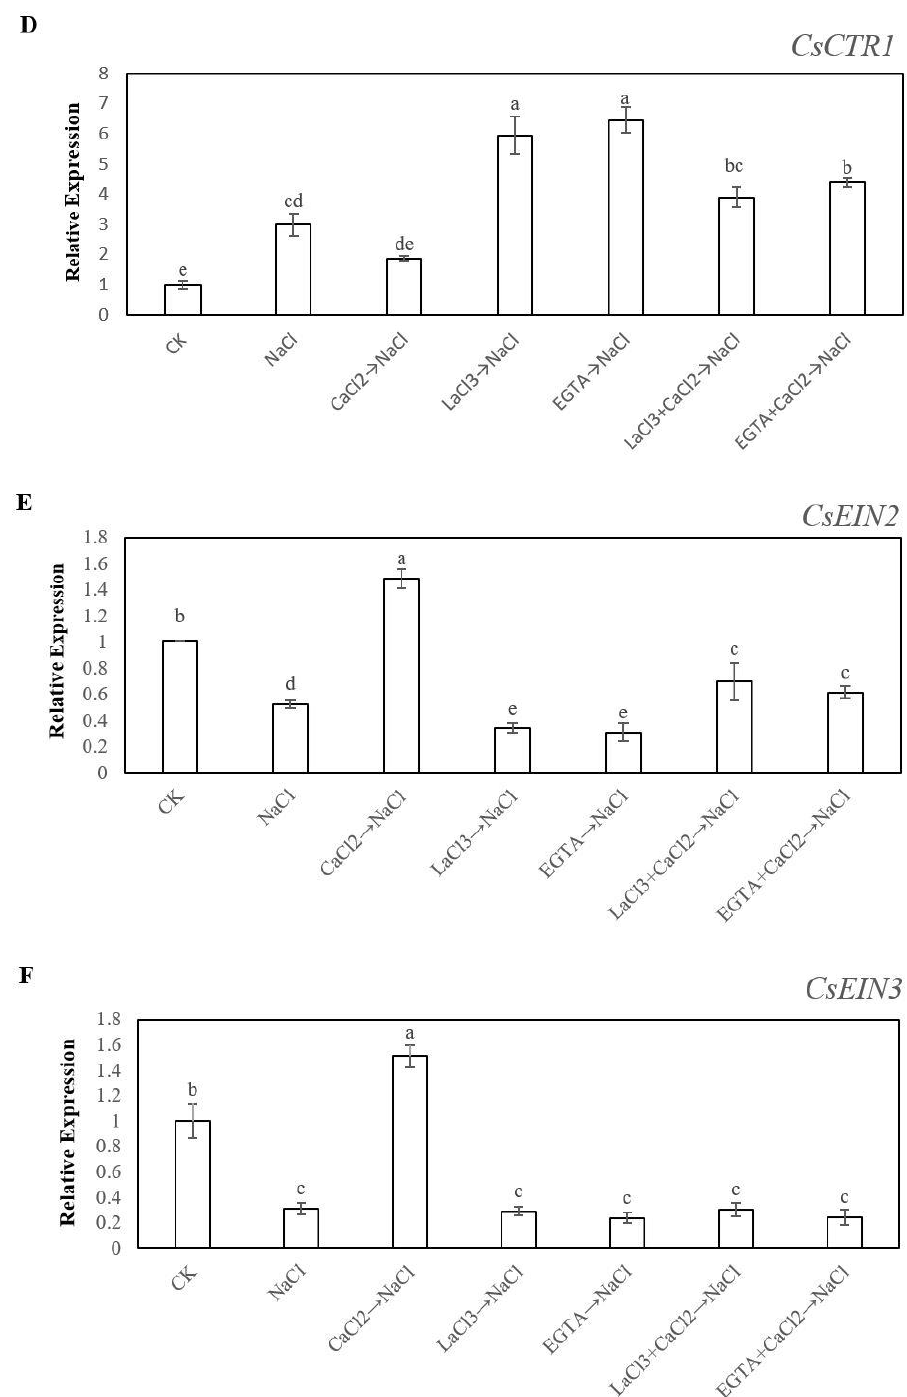
Figure 7. Effects of Ca 2+ on the Expression Levels of CsETR1 ( A ), CsETR2 ( B ), CsERS ( C ), CsCTR1 ( D ), CsEIN2 ( E ), and CsEIN3 ( F ) in cucumber explant under salt stress at 48 h. The primary roots were removed from hypocotyl of five-day-old seedlings. Explants were incubated for five days with distilled water as control, meanwhile the explants were incubated with 13 mM NaCl after being treated with distilled water or 10 µ M CaCl 2 , 500 µ M LaCl 3 , 100 µ M EGTA, 500 µ M LaCl 3 + 10 µ M CaCl 2 , 100 µ M EGTA + 10 µ M CaCl 2 , respectively. The values (means ± SE) are the average of three independent experiments. Bars with different lowercase letters were significantly different by Duncan’s multiple range test ( P <